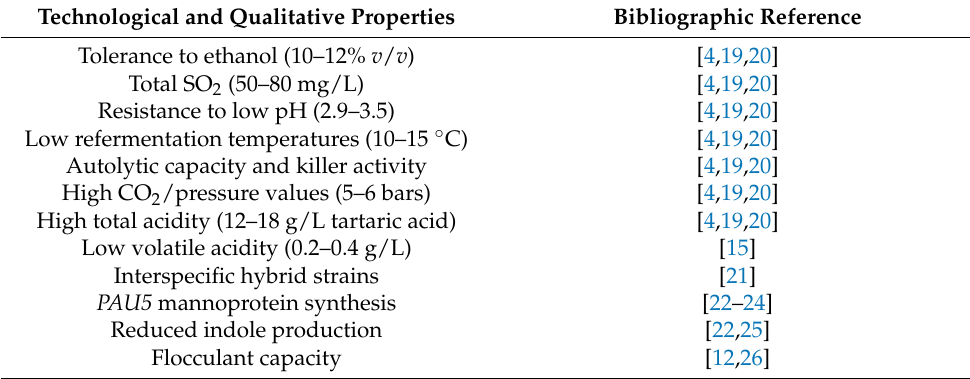
Table 2. Summary of the main technological and qualitative properties of yeast strains for the production of sparkling